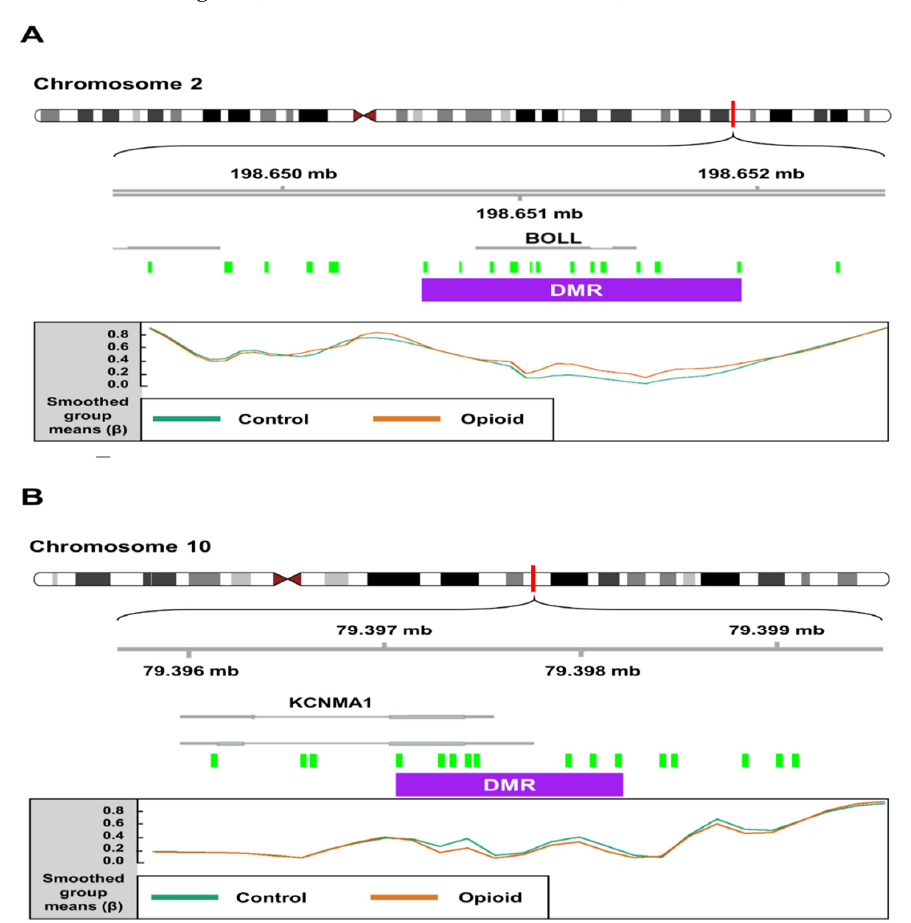
Figure 5. Schematics depicting differentially methylated regions (DMRs) associated with opioid exposure. ( A ) A DMR (1,322 bp; represented by purple box) on chromosome 2 spanning 16 CpG probes (green boxes) mapped to the first exon of the Boule Homolog, RNA Binding Protein gene ( BOLL ). In opioid-exposed samples, methylation levels were 9.02% higher on average at CpG sites within this region relative to control samples (min smoothed FDR = 8.5 × 10 − 9 ). ( B ) A DMR (1,120 bp) on chromosome 10 spanning 10 CpG probes mapped to the first exon of the Potassium Calcium-Activated Channel Subfamily M Alpha 1 gene ( KCNMA1 ). Opioid exposed samples had methylation levels that were an average of 11.8% lower than control samples across this region (min smoothed FDR = 2.6 × 10 − 5 ). Mean normalized beta values across the DMR are shown for each group (control vs. opioid exposed) at the bottom of each panel.